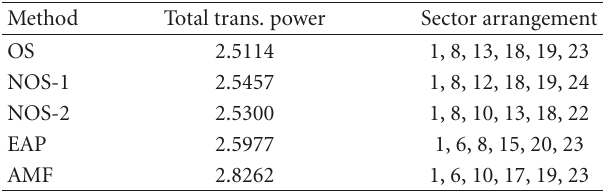
Table 5: Results for the system in Figure 8.